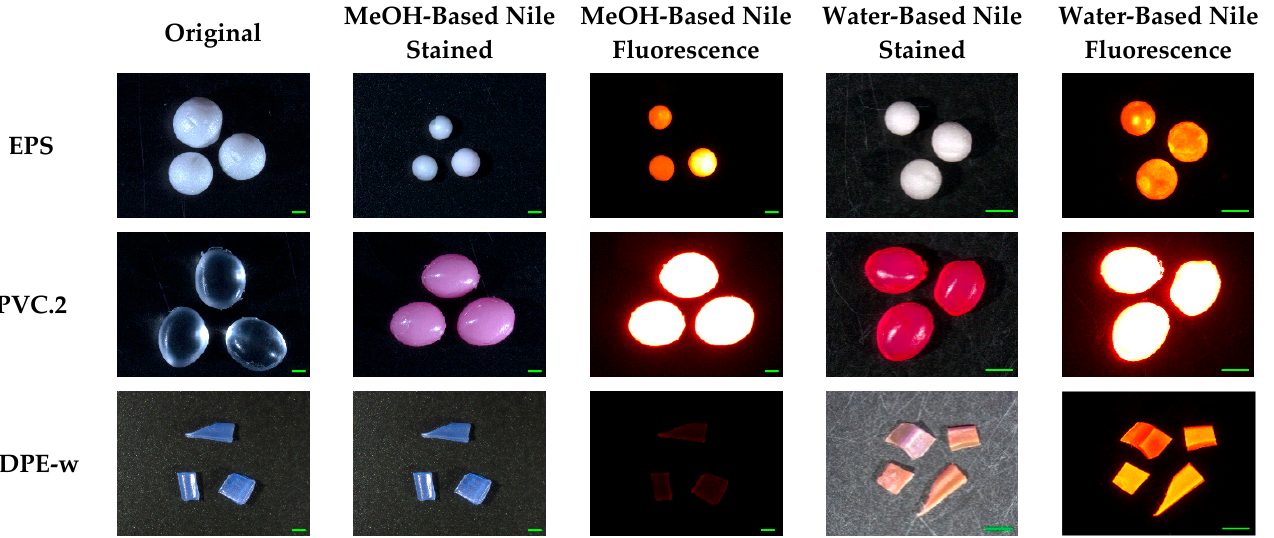
Figure 4. Fluorescence microscope images of EPS, PVC.2, and LDPE-w stained by 2 µg/mL metha- nol-based Nile red and 2 µg/mL water-based Nile red at 70 °C for 3 h. Scale bar denotes 1 mm. In fluorescence microscopy, the magnification used to observe MPs affects the fluo- rescence intensity [42]. As such, we chose 8× and 40× as standard magnifications to ob- serve all MPs. Our CA particles had a size of 390 ± 290 µm. Pink textile dyes and water- based Nile red resulted in the maximal red fluorescence intensity (255) at 40× magnifica- tions. However, at 8× magnification, the intensities dropped to 13.4 ± 2.9 and 145.4 ± 15.9, respectively. This suggests that smaller sizes of MPs may appear to show stronger fluo- rescent signals, as they will be observed at higher magnifications. Compared with undyed MPs, there was no significant change in the surface mor- phology after 3-h staining at 70 °C. Additionally, identical FTIR spectra were observed for all polymers before and after staining (Figure S7), which corroborates that these dyes are usually not covalently bonded to polymers, but, according to Gewert et al., adsorbed to them via “van der Waals interactions with additional dipole interactions” in polar poly- mer types [23,44]. 3.5. Stability of Fluorescence Fluorescence stability was assessed for the pink textile dyes along with Nile Red, due to their higher intensities. Stained particles were placed in four common solutions (fresh- water, seawater, sediment slurry, and returned activated sludge) to test the fluorescence stability at room temperature. All these dyes were fluorescently stable under these solu- tions for 7 days under simulated sunlight (Figure S8). This stability is attributed to strong interactions between polymers and dyes due to their adsorption to the surface or incor- poration into polymers. While these results are promising, more study is needed on their stabilities over longer times and in harsher solutions. Red fluorescence intensities of MPs stained by Nile red at room temperature were observed to reduce significantly after one month due to the easy desorption of dye from the surface of polymers [36]. KOH and non- polar solutions, which are common in chemical digestions for MP extractions, have also been reported to weaken the fluorescence intensities of LDPE fragments, HDPE mi- crobeads, and polyacrylonitrile fibers stained at 70 °C [12].